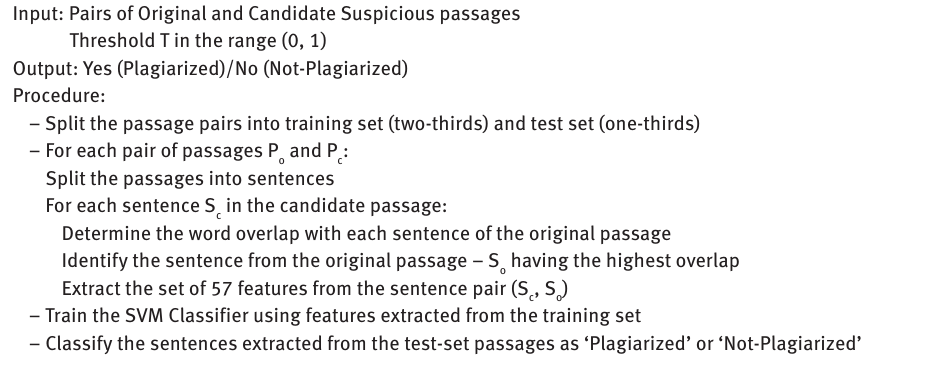
Algorithm: Plagiarism Detection by Sentence-level